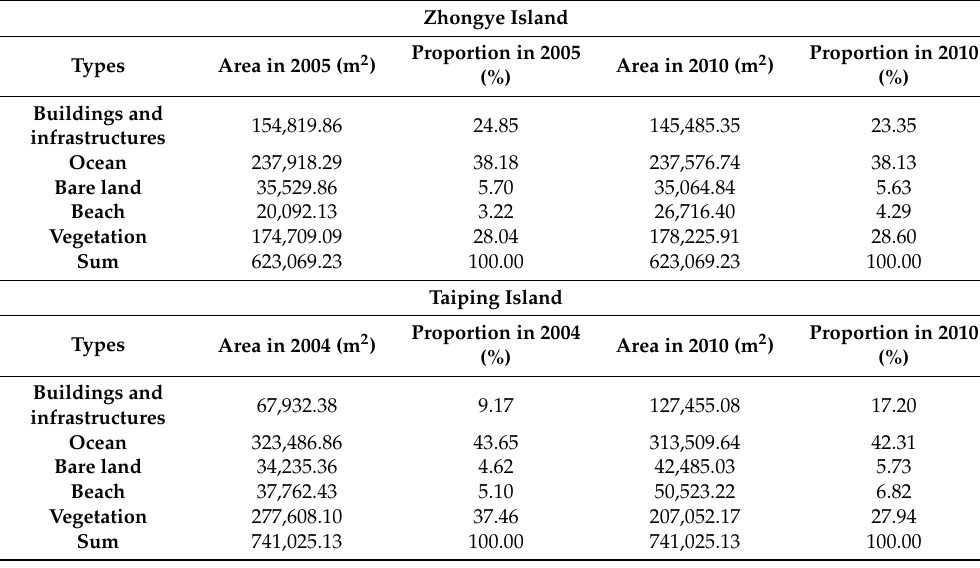
Table A1. The area and proportion of reef island surface and coral reef